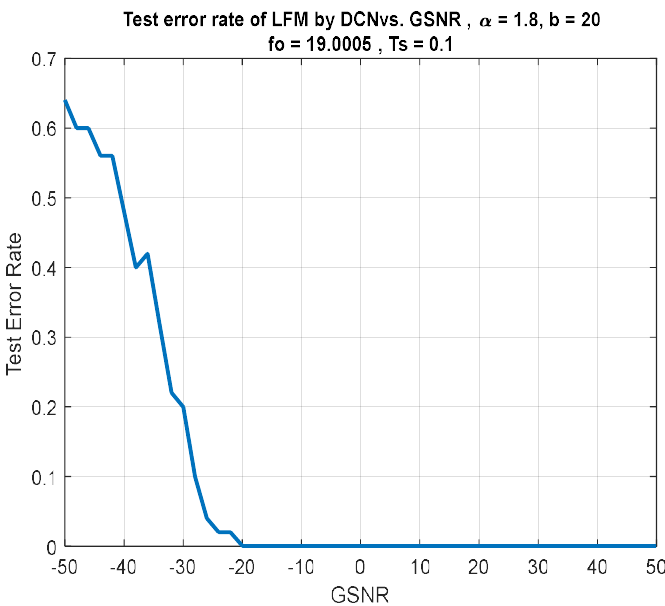
Figure 33. Test error rate for SE of noisy LFM by CNN, where f o = 19.0005.